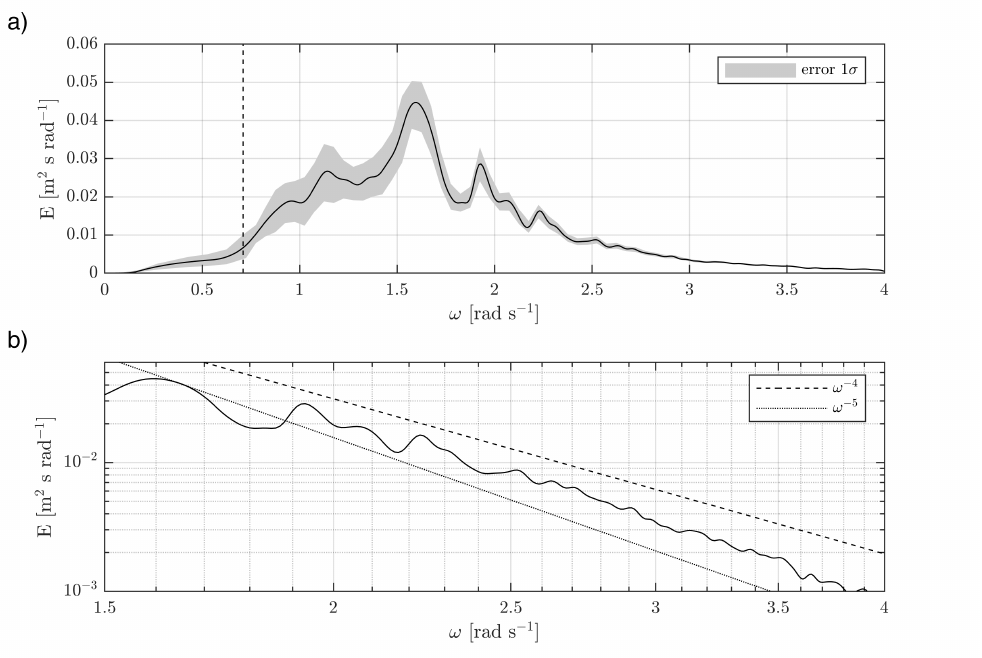
Figure 2. In ( a ), an exemplaric omnidirectional variance density spectrum with the 1 σ -error area indicated in grey is shown. The measurement was taken on 5 May 2020 close to Westerland at 12:50 UTC. Subfigure ( b ) shows the high frequency tail with logarithmic